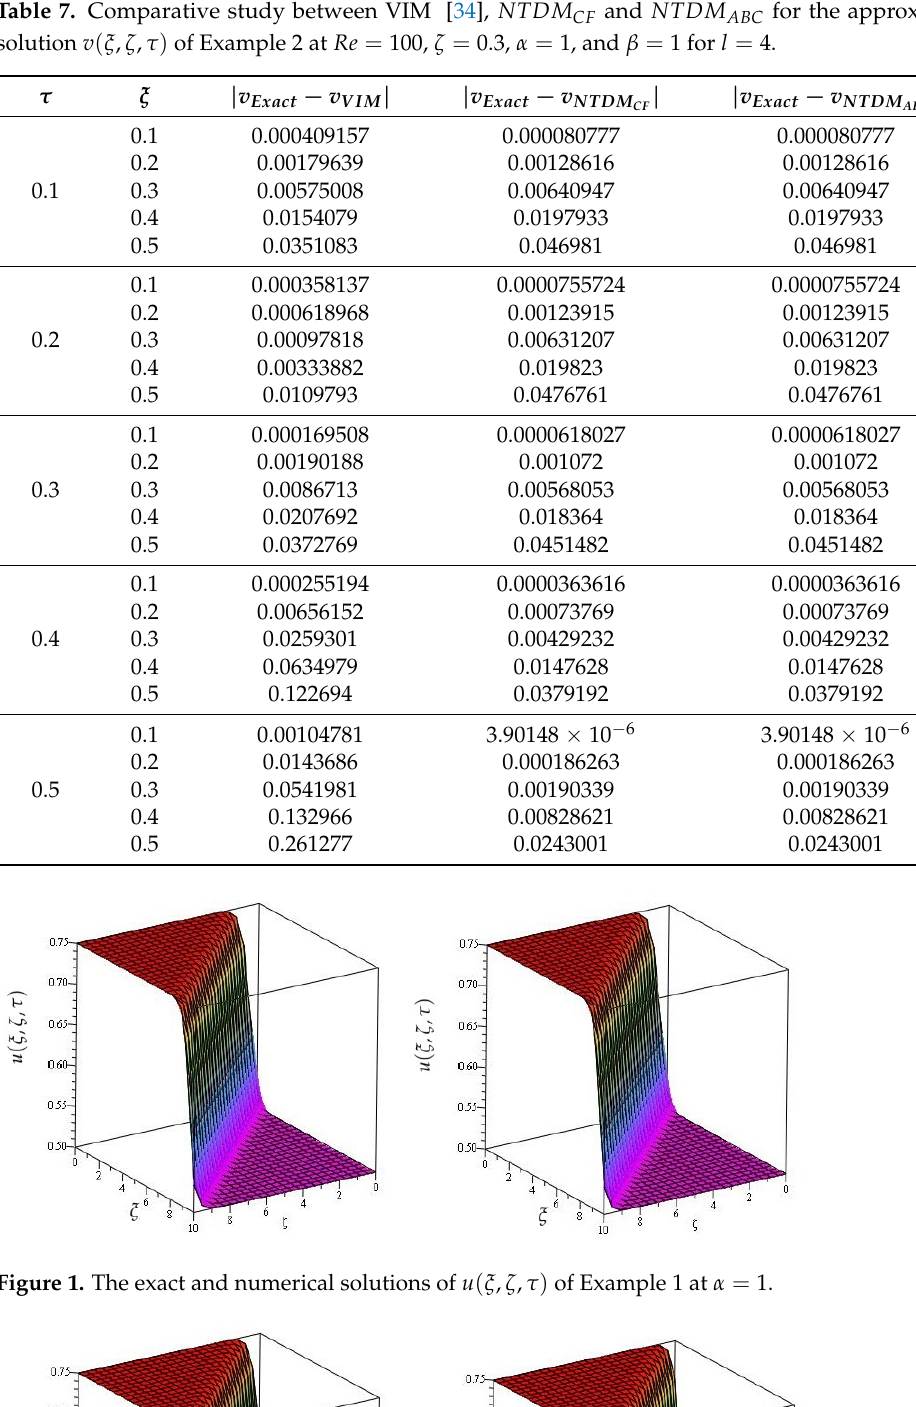
Table 7. Comparative study between VIM [34], NTDM CF and NTDM ABC for the approximate